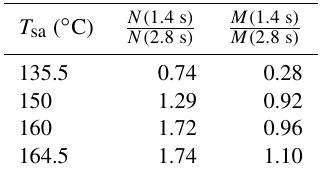
Table 2. The ratios of the measured number concentrations and mass concentrations with the residence times of 1.4 and 2.8s, in measurement set 4. The values are corrected with the dilution ratio of the bridge diluter and with the diffusional losses in the sampling lines after the ejector diluter; thus, the values correspond with the distributions existing after the ejector